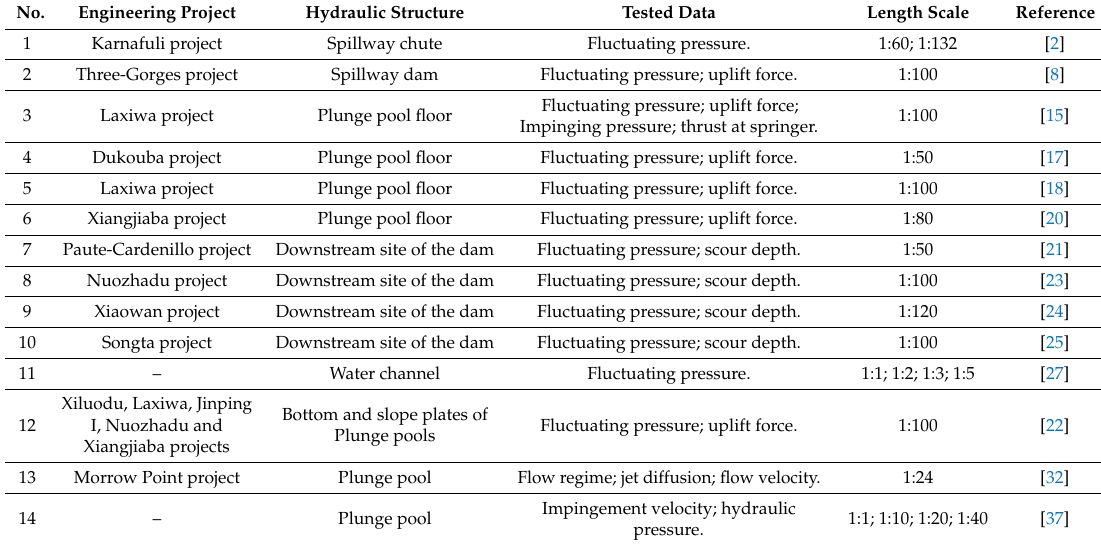
Table 1. Basic information of the physical models involved in the references.